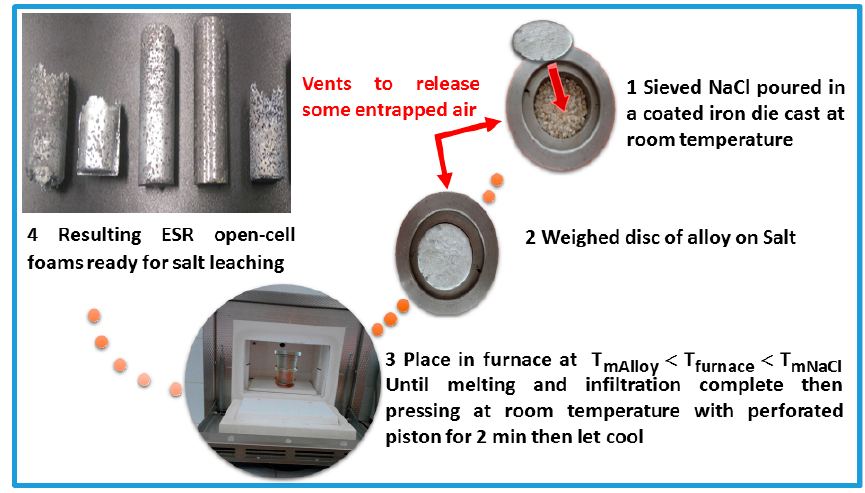
Figure 1. Steps of the ESR process and the resultant open-cell foams made by zamak 5. Sieved salt was poured in a coated iron mould and manually shacked so that it ar- ranged tightly in maximum-dense packing. A weighted disc of zamak 5 alloy was pre- pared by the same mould so that it would later fit and cover the top of the salt later, and this allows us to gain 15 mm of excess salt after fusion. When placed in a furnace at a